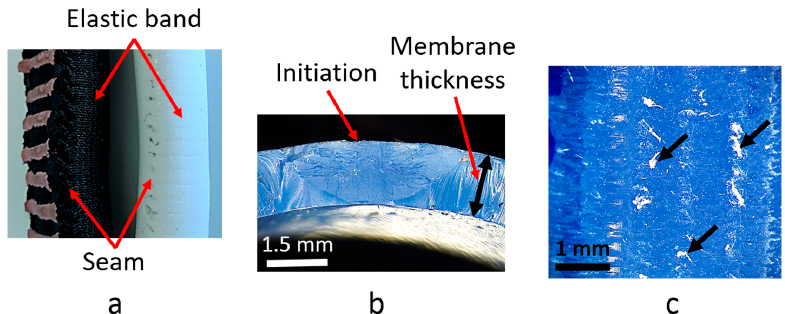
Figure 11. Visual ( a ) and optical microscope ( b , c ) analysis of actuator failure. ( a ) Sleeve and membrane of a small actuator, still operational after 700,000 cycles. Sleeve and seam imprints are visible in the membrane. ( b ) Section view of the crack in a large bending actuator. Initiation began on the outside surface of the membrane and propagated through the membrane, forming a semi-circular pattern (magnification: 20). ( c ) White fibers are embedded in the external surface of the large bending actuator. The picture was taken near the crack, i.e., in the middle of the actuator (magnification: 16).